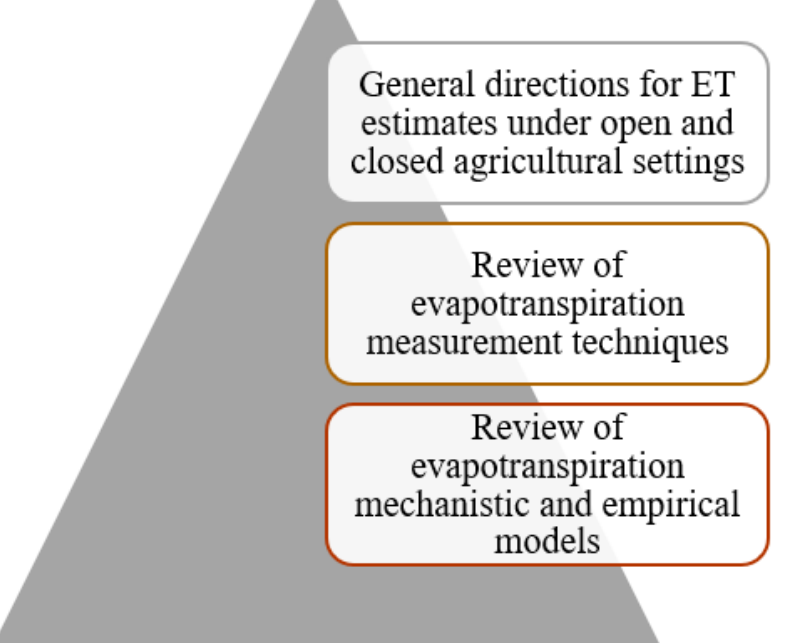
Figure 1. Review methodology.